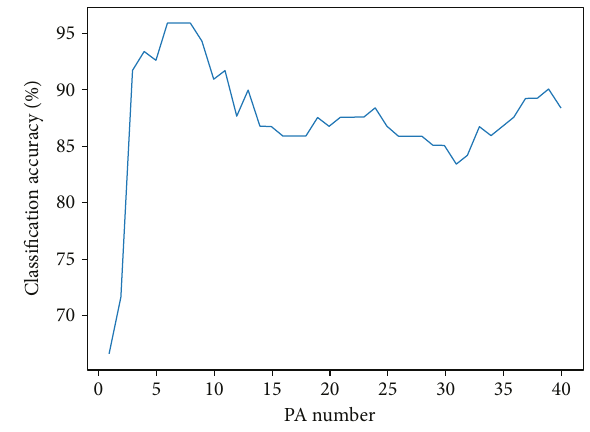
Figure 3: The classi fi cation accuracy rate of principal component